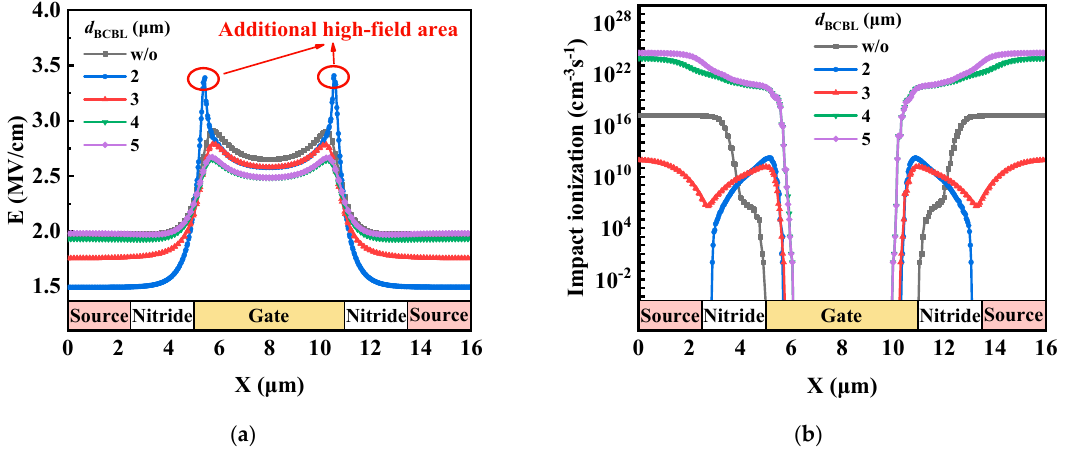
Figure 4. Distributions of ( a ) electric field and ( b ) impact ionization concentration near the gate in the BCBL-VFET with the changed d BCBL .